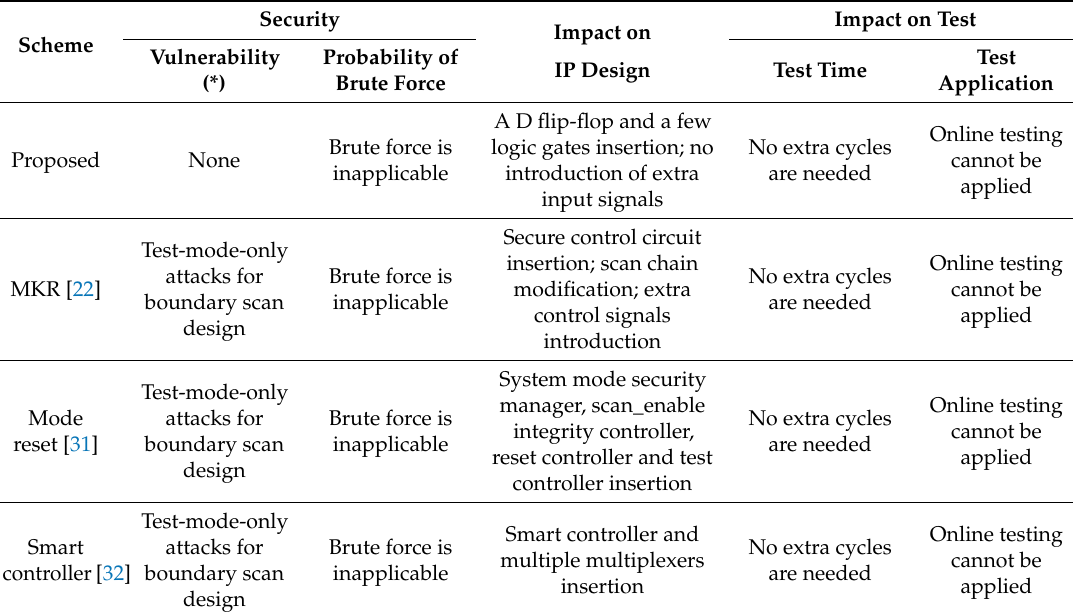
Table 5. Comparison of different security scan